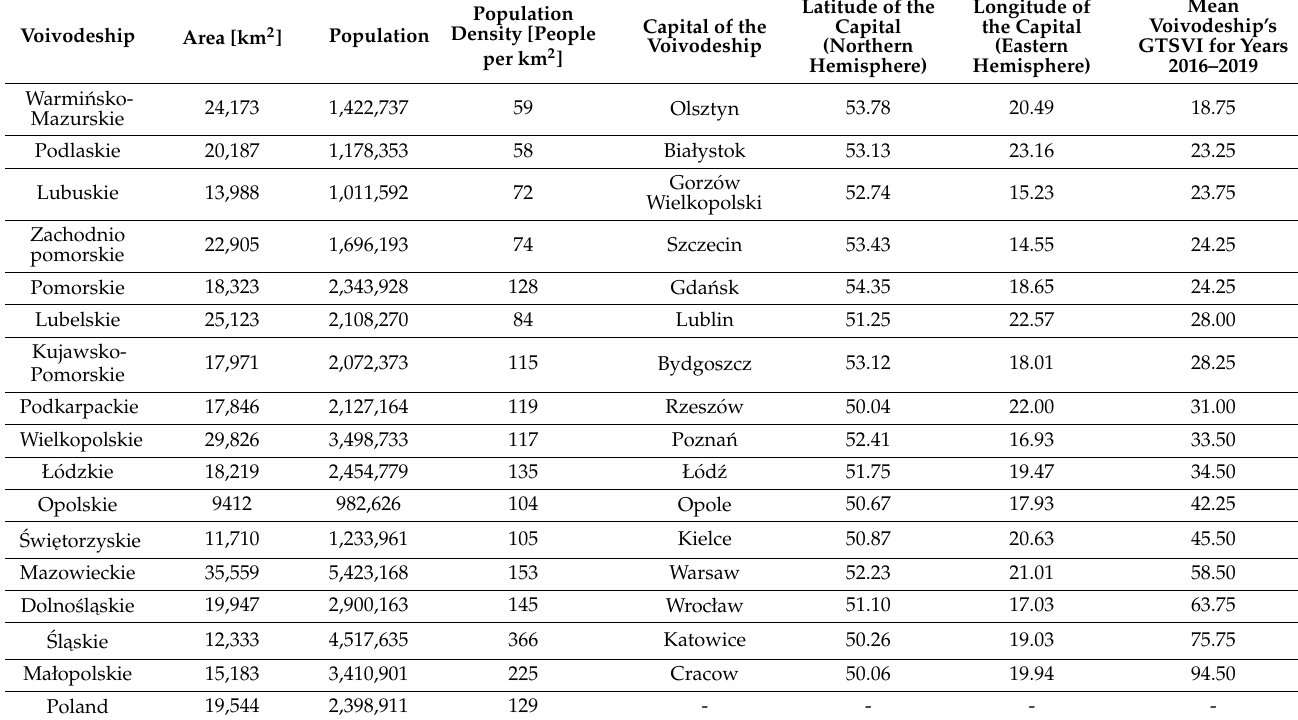
Table 1. General geographical and demographical characteristics of voivodeships of